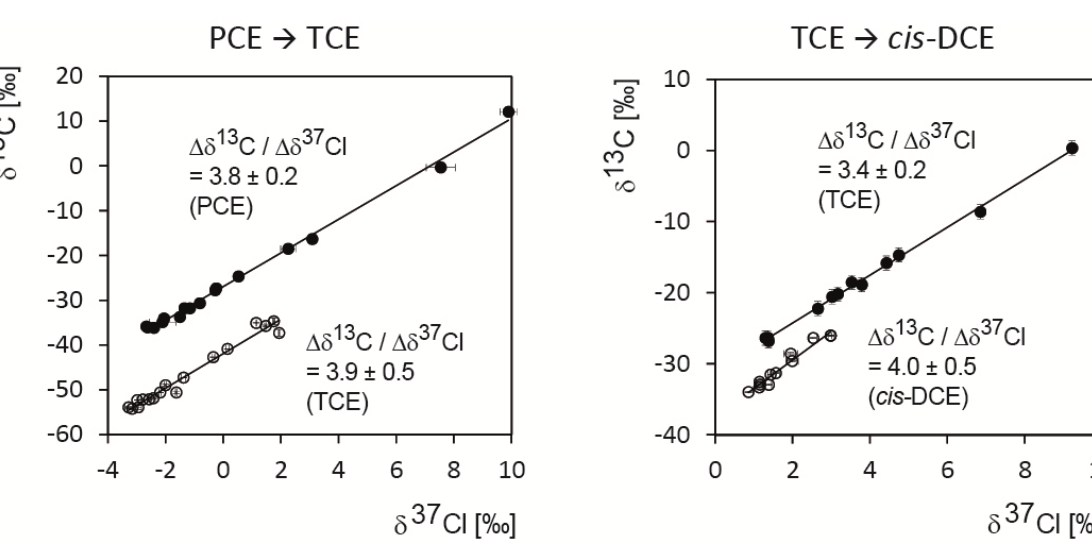
Figure 7. Dual element (carbon and chlorine) isotope plots for degradation of PCE toTCE by Desulfitobacterium sp. strain Viet1, and of TCE to cis -DCE by Geobacter lovleyi strain SZ. Error bars are standard deviations, uncertainties are 95% confidence